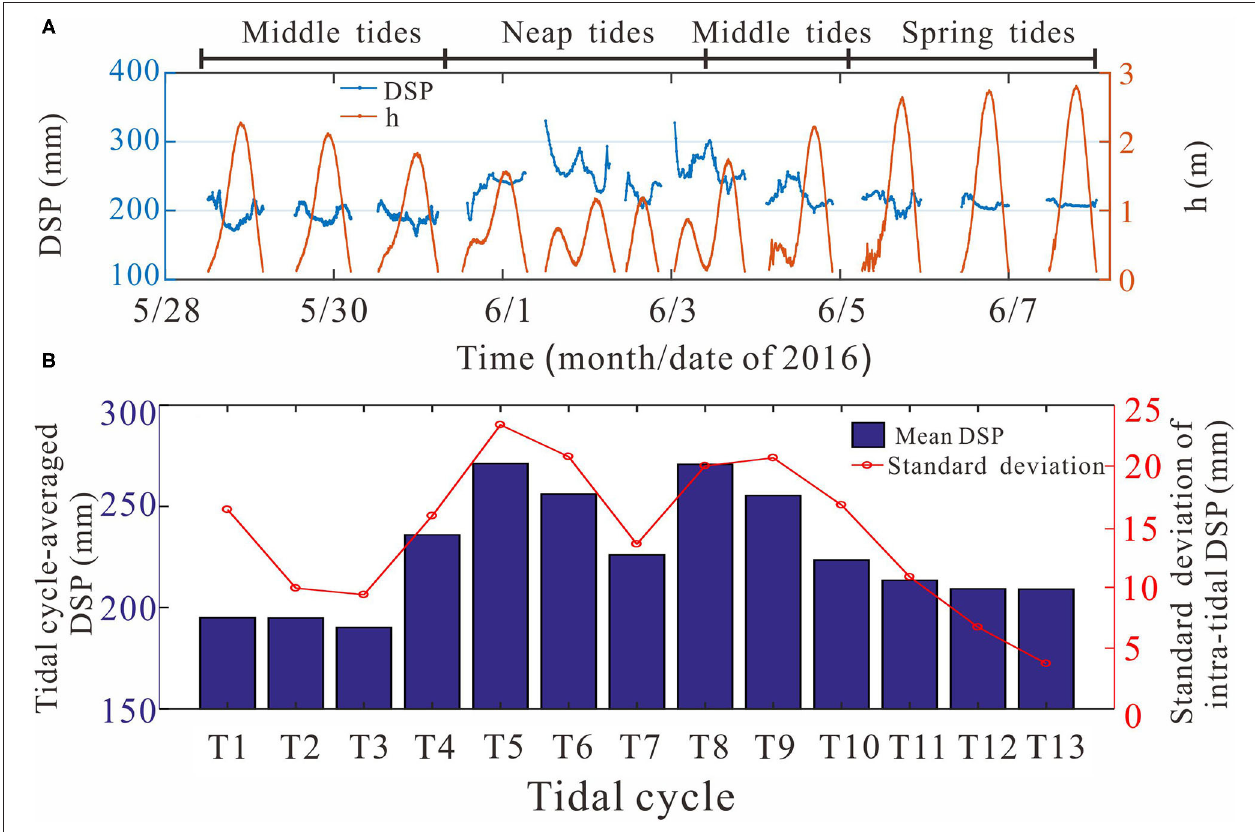
FIGURE 3 | Time series of (A) distance of seabed to acoustic Doppler velocimeter (ADV) probe (DSP, blue line) against h (red line); (B) tidal cycle-averaged distance of the seabed to the ADV probe (DSP, blue bars) and the SD of the intra-tidal distance of the seabed to the ADV probe of each tidal cycle (red circles and lines).